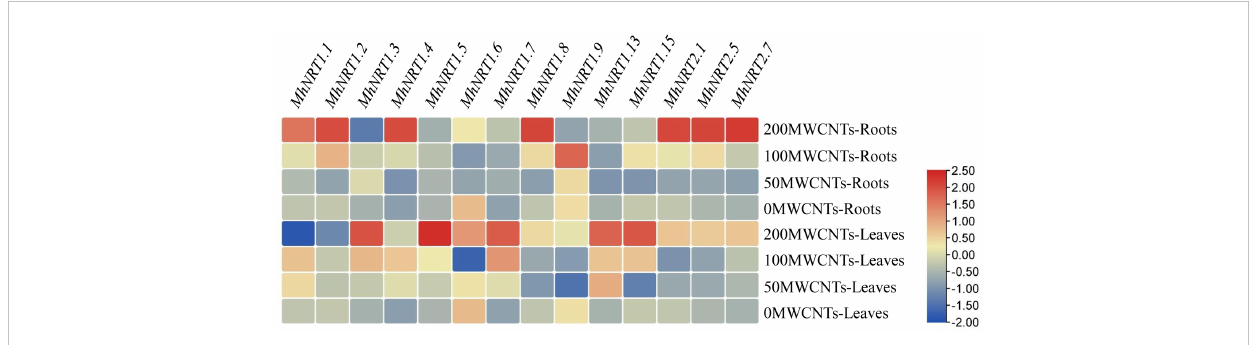
FIGURE 5 Response of MhNRTs expression levels in Malus hupehensis seedlings to MWCNTs treatments. For each gene, expression in roots or leaves of plants under the 0 concentration of MWCNTs was de fi ned as 1, and corresponding fold-changes were calculated under other concentrations of MWCNTs. The heatmap was constructed using